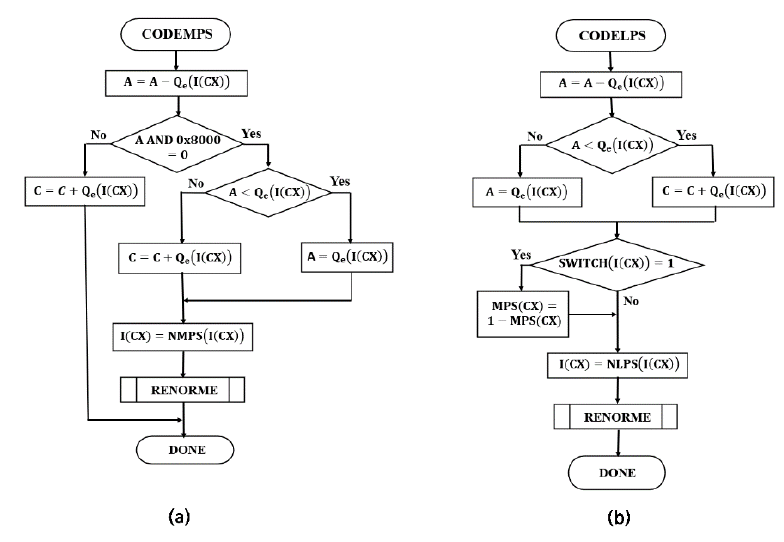
Figure 2. ( a ) CODEMPS procedure, ( b ) CODELPS procedure.